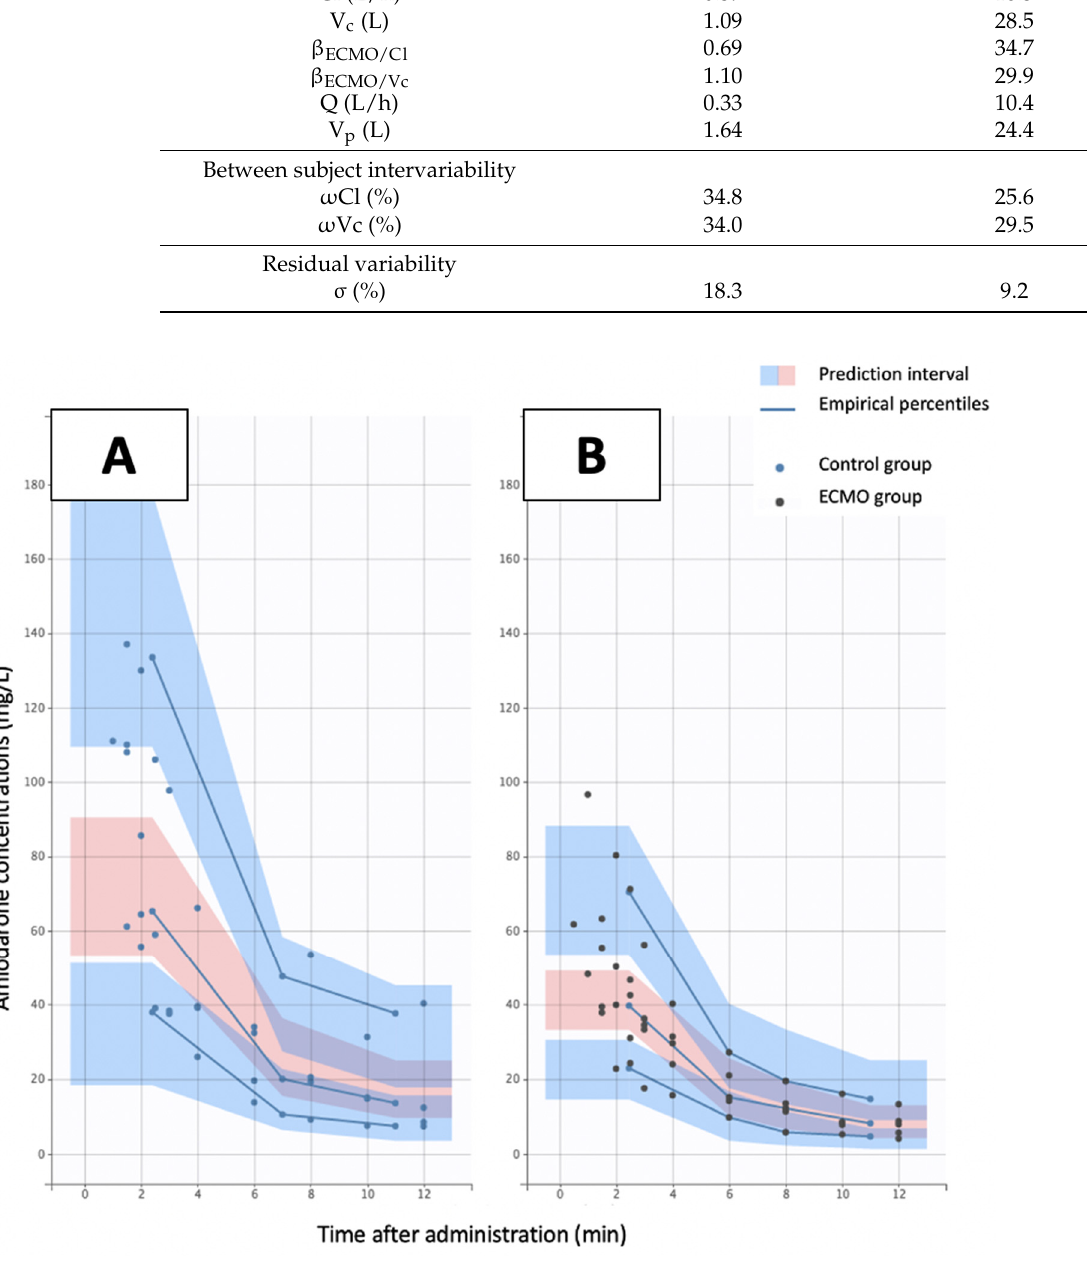
Figure 4. Predicted—Corrected Visual Predictive Check of the final amiodarone model. The observed data (blue spots for control group and black spots for VV ECMO group) were plotted with the median line, 10th and 90th percentiles of the predictions. The 90% confidence intervals of the median are represented by the pink shaded area. Data are presented for control ( A ) and ECMO ( B ) groups. Table 3. Estimated population parameters for amiodarone using a modeling approach. Between- Subject Variability (BSV) expressed as the coefficient of variation of the associated non-log-trans- formed parameter, clearance (Cl), central distribution volume (V c ), peripheric compartment (V p ), relative standard error (RSE) (standard error of the estimate divided by the estimate and multiplied by 100), impact of ECMO on clearance ( β ECMO/Cl ), impact of ECMO on central distribution vol- ume( β ECMO/Vc ), ω , coefficient of variation for between-subject variability; σ , parameters of error model. Parameter